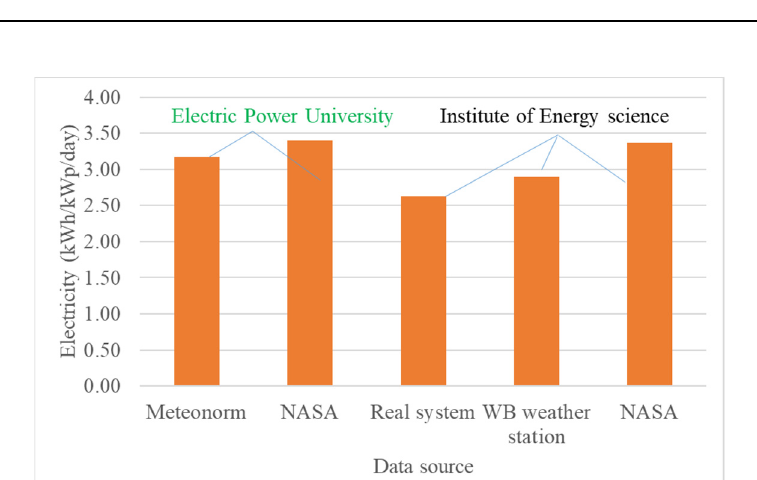
Table 5. Comparison parameters of solar power stations in Hanoi city, Vietnam.